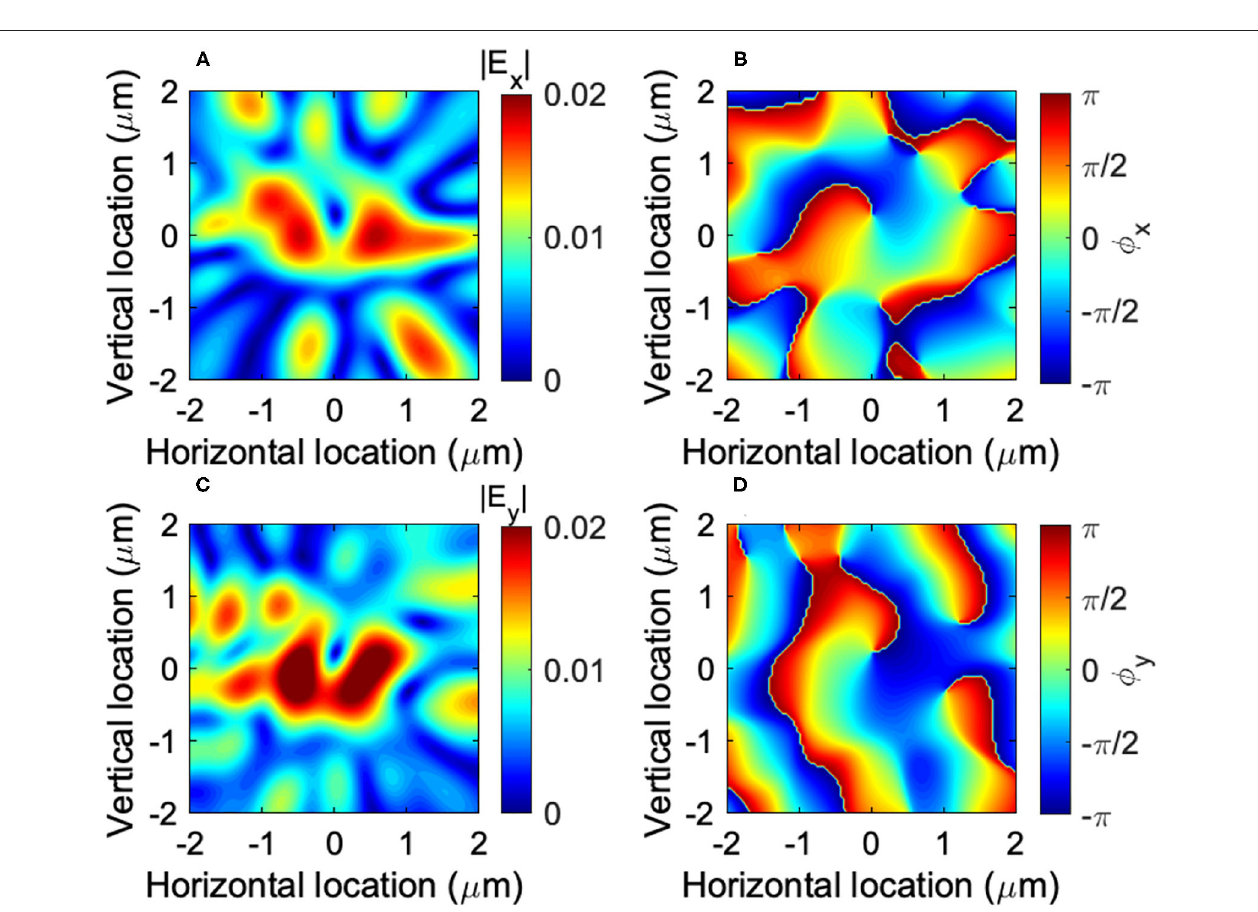
FIGURE 5 | Right vortex generated from the gear of N above the gear. (A) The amplitude ( field E y . They show E y